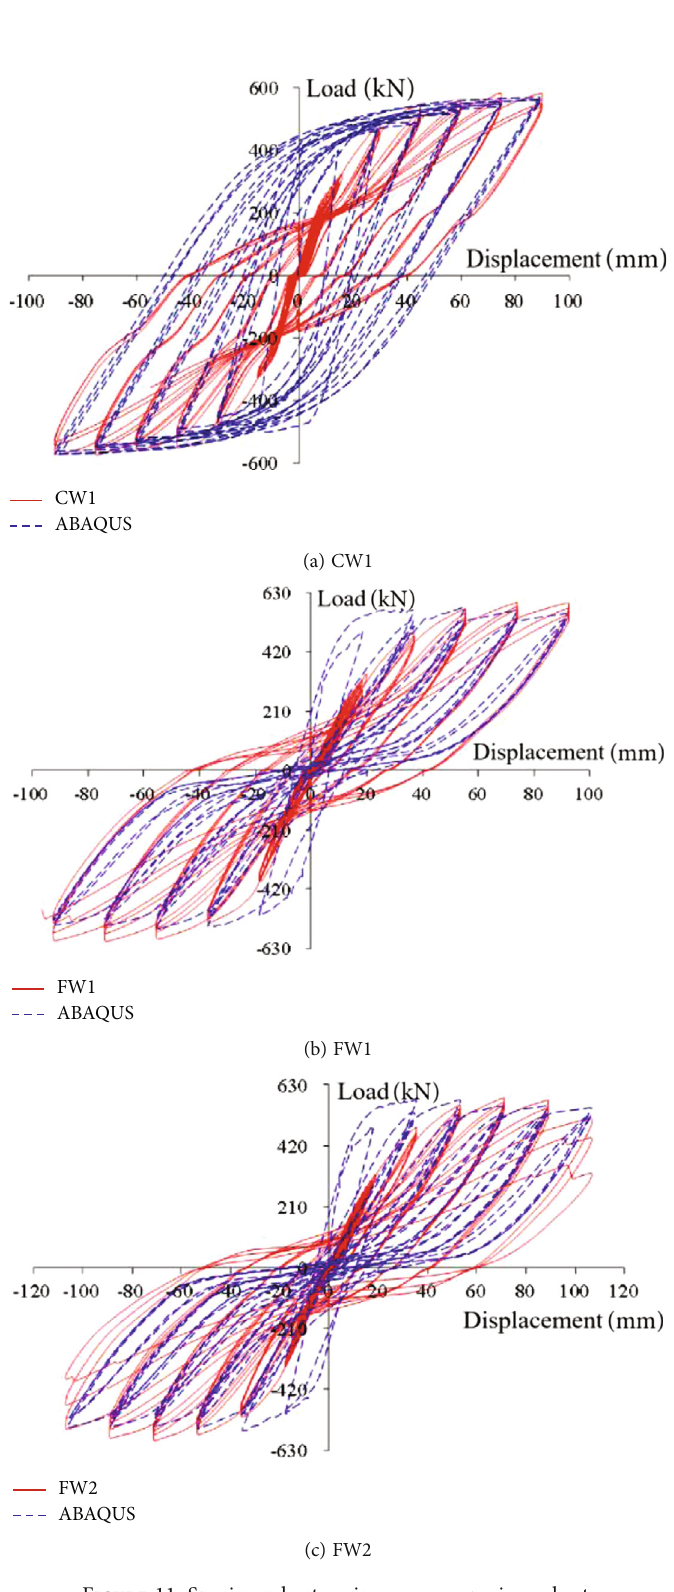
Figure 11: Specimen hysteresis curve comparison